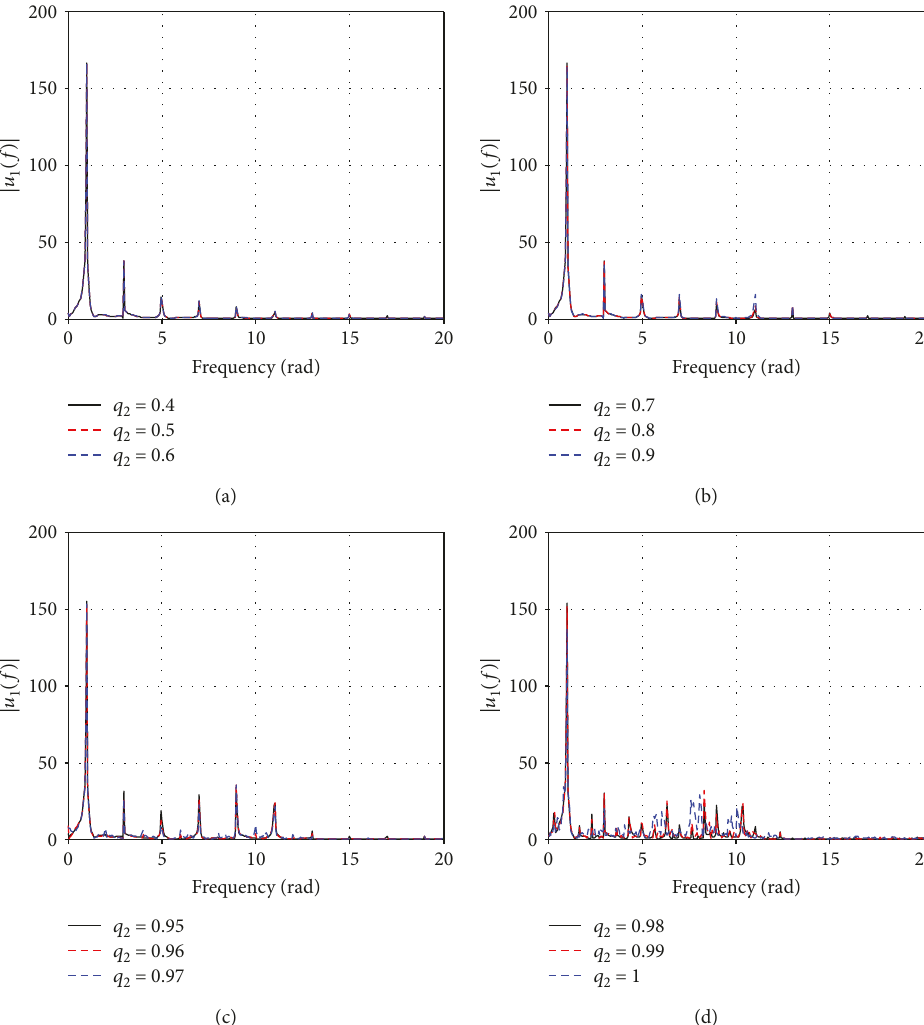
= 0 4 , q = 0 5 , and q = 0 6 . (b) Power spectral density 2 2 2